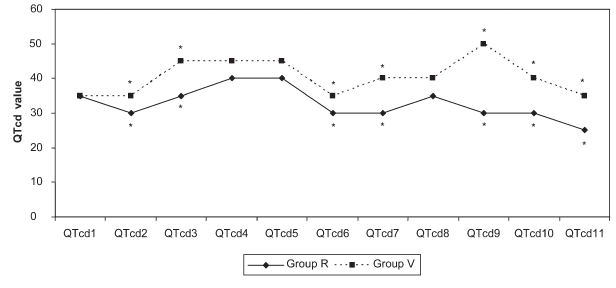
Figure 5 - QTcd values in the two study groups